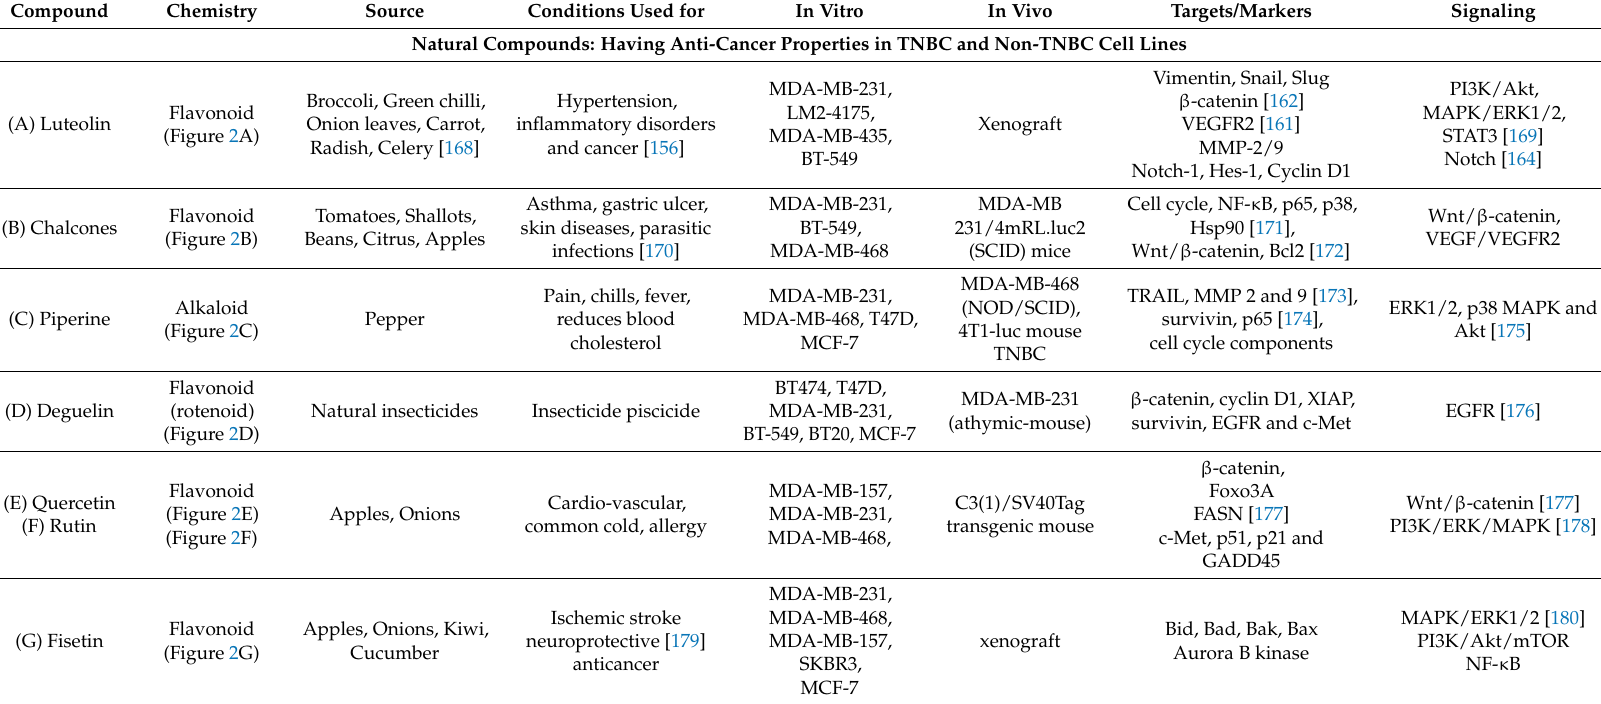
Table 2. Natural substances from plants/fungus indicated in TNBC treatment. Natural compounds mitigate tumor growth by modulating different cell signaling pathways. This table provides an overview of the selected compounds, their potential targets, the signaling pathways involved and experimental models used. Also included is Asparagine, an amino acid and natural compound with pro-carcinogenic effect in TNBCs. Certain non-TNBC cell line (such as MCF-7, T47D, SKBR3 and BT474) related studies have also been mentioned in the table. While the MCF-7 and T47D cells express both the estrogen receptor (ER) and progesterone receptor (PR), the SKBR3 cells express only the human epidermal growth factor receptor 2 (HER2) and are devoid of ER or PR. On the other hand, the BT474 cells express all the three (ER, PR and HER2) receptors. Breast cancers devoid of these three receptors are classified as TNBCs (MDA-MB-231, MDA-Mb-468, MDA-MB-435,